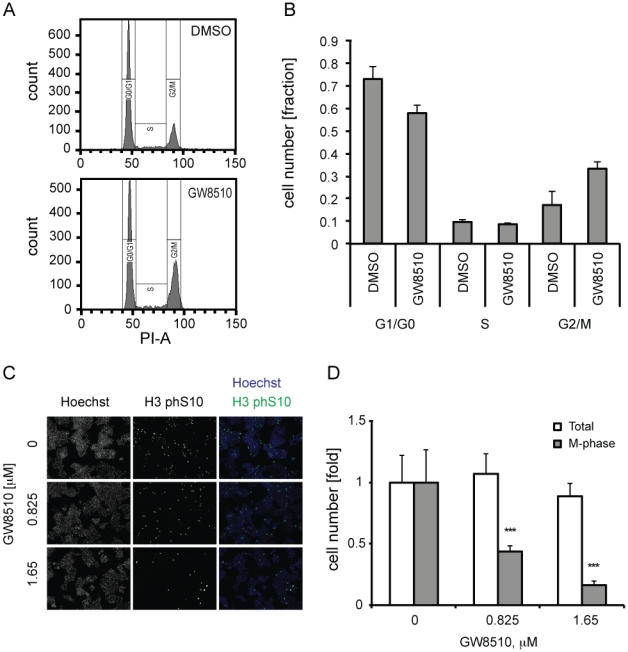
Cell-cycle effects of GW8510 treatment.(A) FACS-generated histograms of propidium iodide stained cells treated with either vehicle control or GW8510 for 3 days. (B) Quantification of cell-cycle distributions from gated cellular populations in A expressed as percentage of the total cellular population. Data represent the mean ± SD of two biological replicates. (C) and (D) M-phase immunofluorescence analysis and quantification using histone H3 phospho-Ser10 as a mitosis marker. Total cells were counted using Hoechst nuclear stain. Representative images are shown for Hoechst, histone H3 phospho-Ser10, and overlay at indicated GW8510 concentrations. Values are expressed as fold over vehicle-treated controls. Data represent the mean ± SD of at least 3 biological replicates; ***p<0.001.